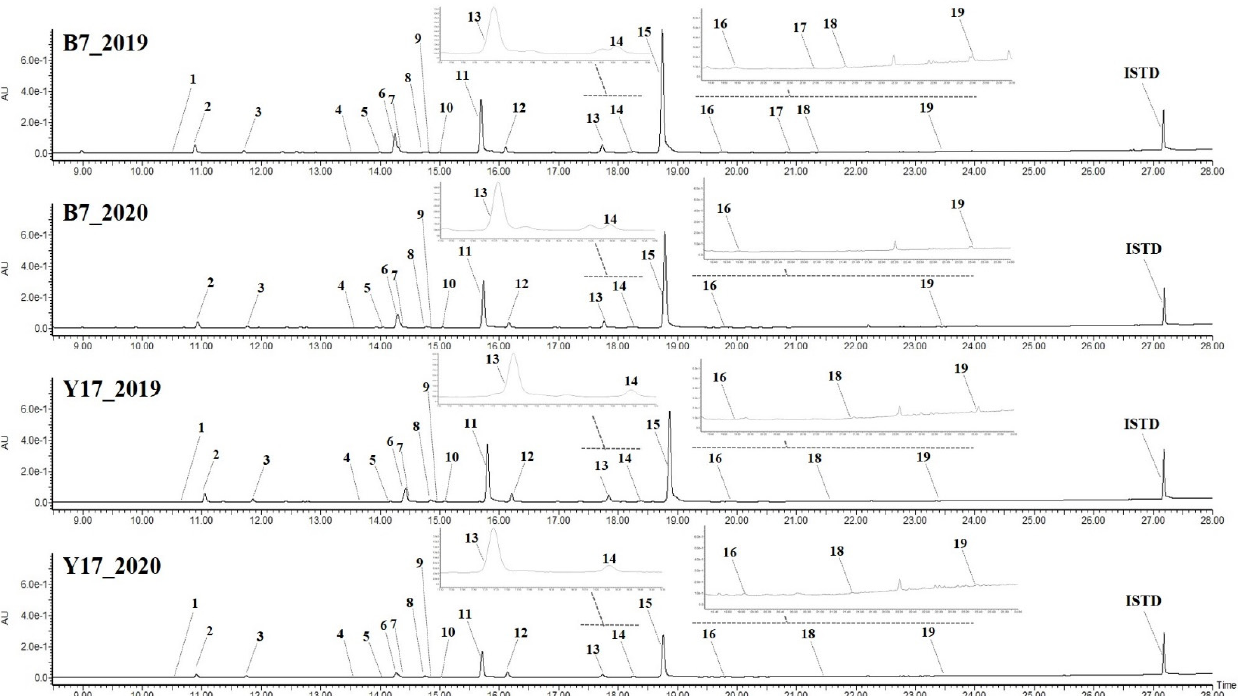
Figure 2. UPLC-DAD chromatogram of 19 isoflavone derivatives (wavelength at 254 nm) from soybean resources B7 and Y17 (year 2019 and 2020). Compound names are presented according to peak numbers in Table 4. ISTD (internal standard): 6-methoxyflavone 50 ppm.